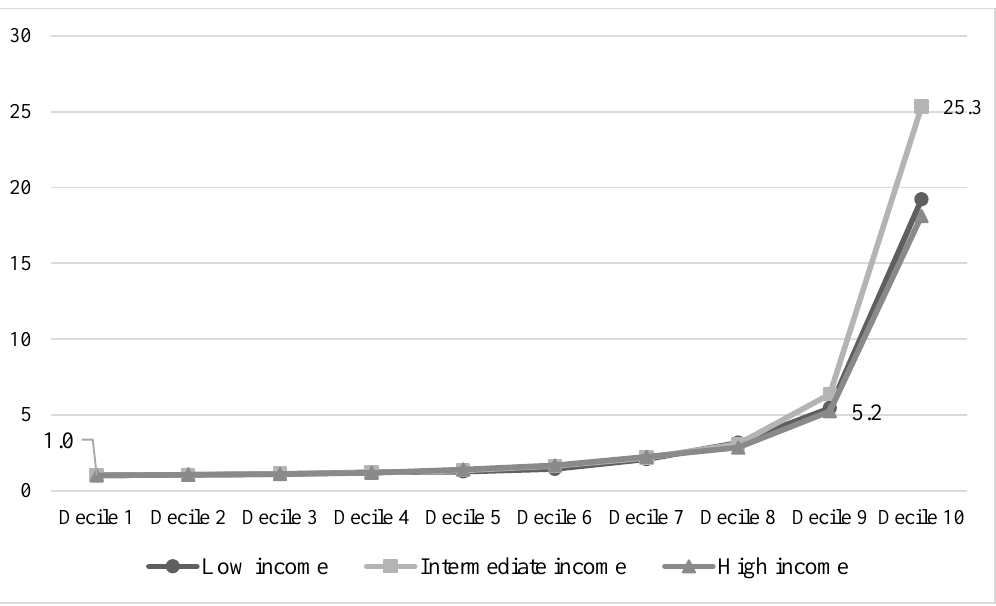
Figure 2: Average predicted quantities of units of cheap alcohol (<£0.50) purchased per week per household within income and decile